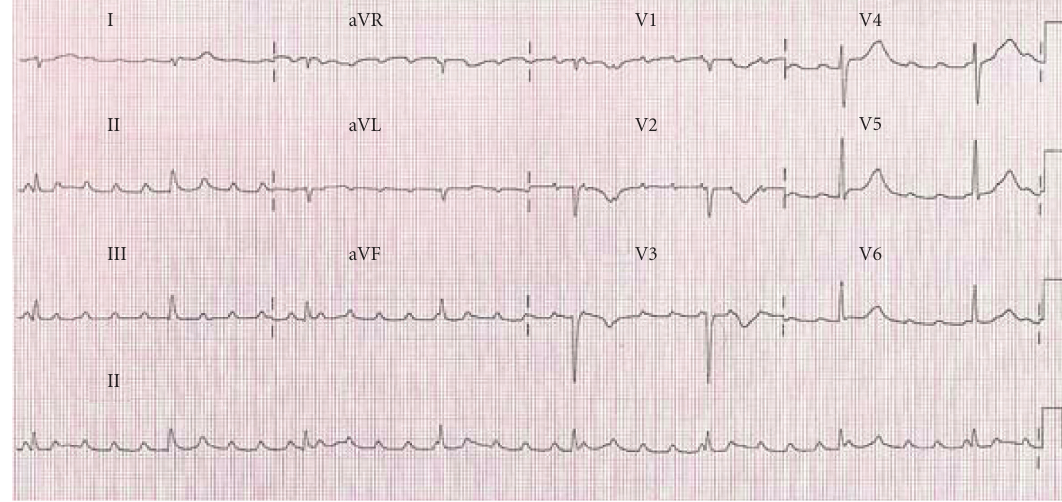
Figure 1: Twelve-lead ECG demonstrating a complete atrioventricular block.